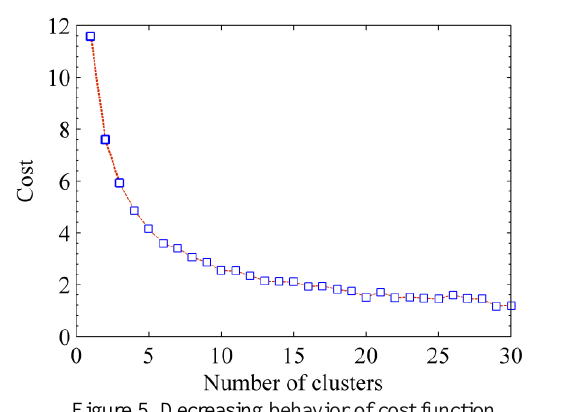
Figure 7. Clusters’ spatial